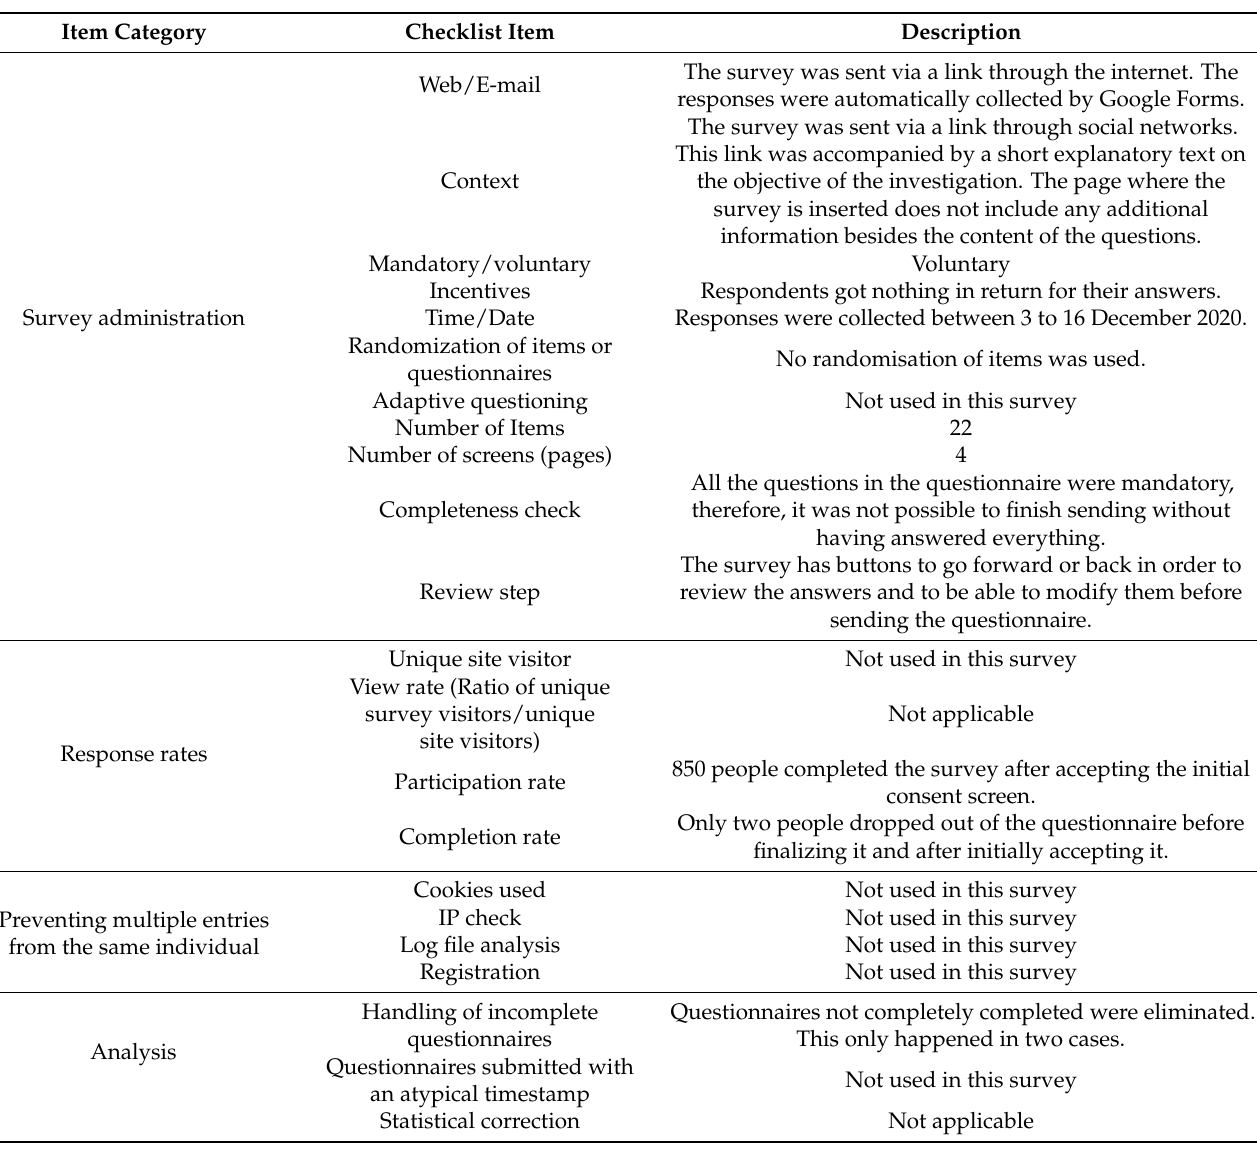
Table A2. Aspects considered by nurses to estimate the empowerment of their